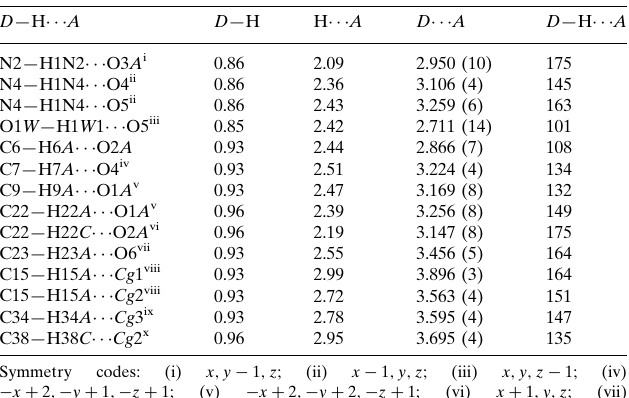
Siemens SMART CCD area- detector diffractometer